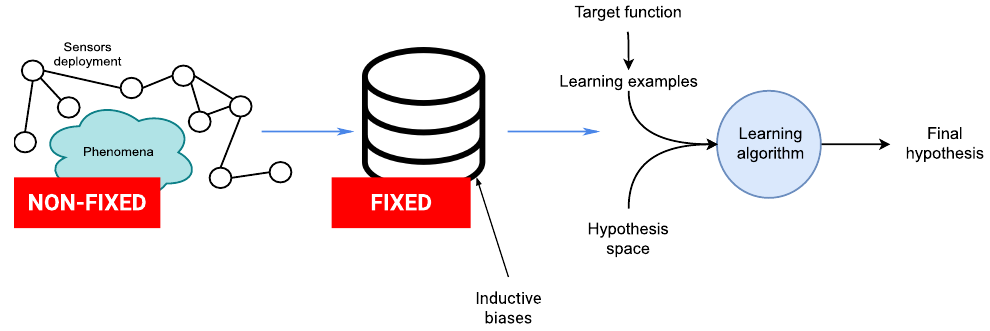
Figure 9. ( left ) Sensor-rich environment depicting a deployment of sensors surrounding a phenom- ena of interest. ( center ) Data repository where the fixed nature of the inductive biases used during the data generation process is highlighted. ( right ) The different components of the traditional learning processes. Learning processes in the case of sensor-rich environments deal very often with evolving and non-fixed settings materialized by the sensor deployments as well as the phenomenon of interest. This contrasts with the traditional setting where inductive biases are fixed beforehand and assumed to remain relevant during the entire